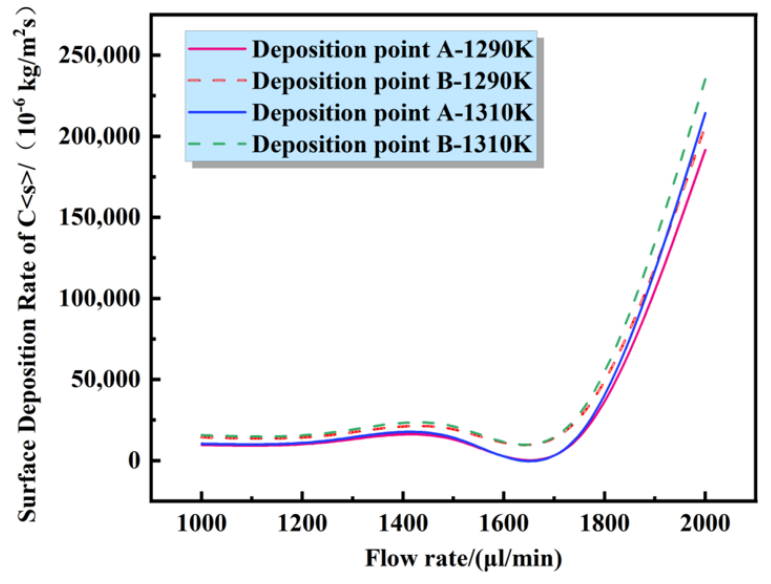
Figure 6. Graph of carbon deposition rate versus gas flow.